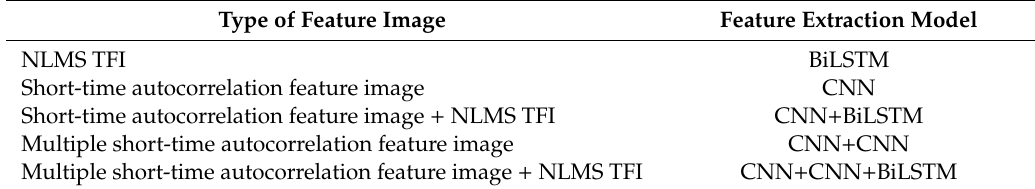
Table 4. Di ff erent feature images and feature extraction models.